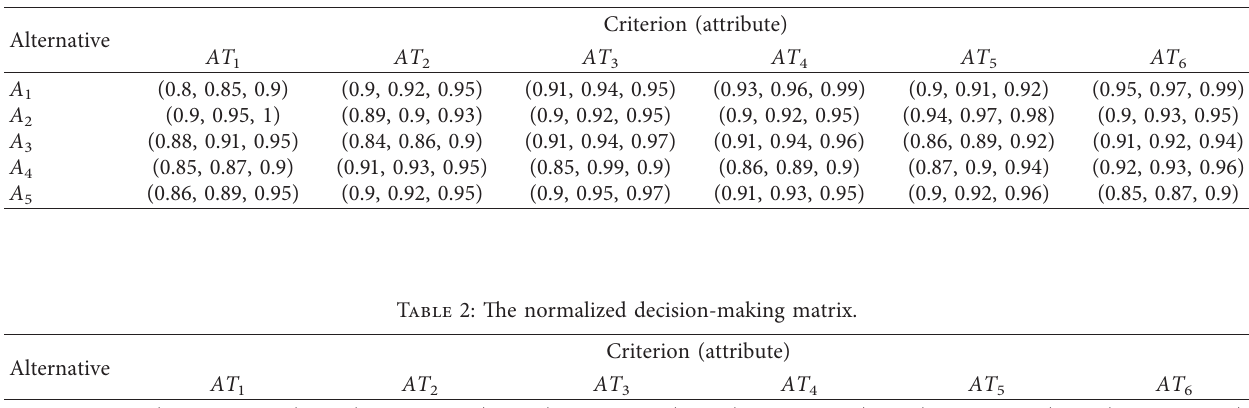
Table 1: The decision-making matrix.